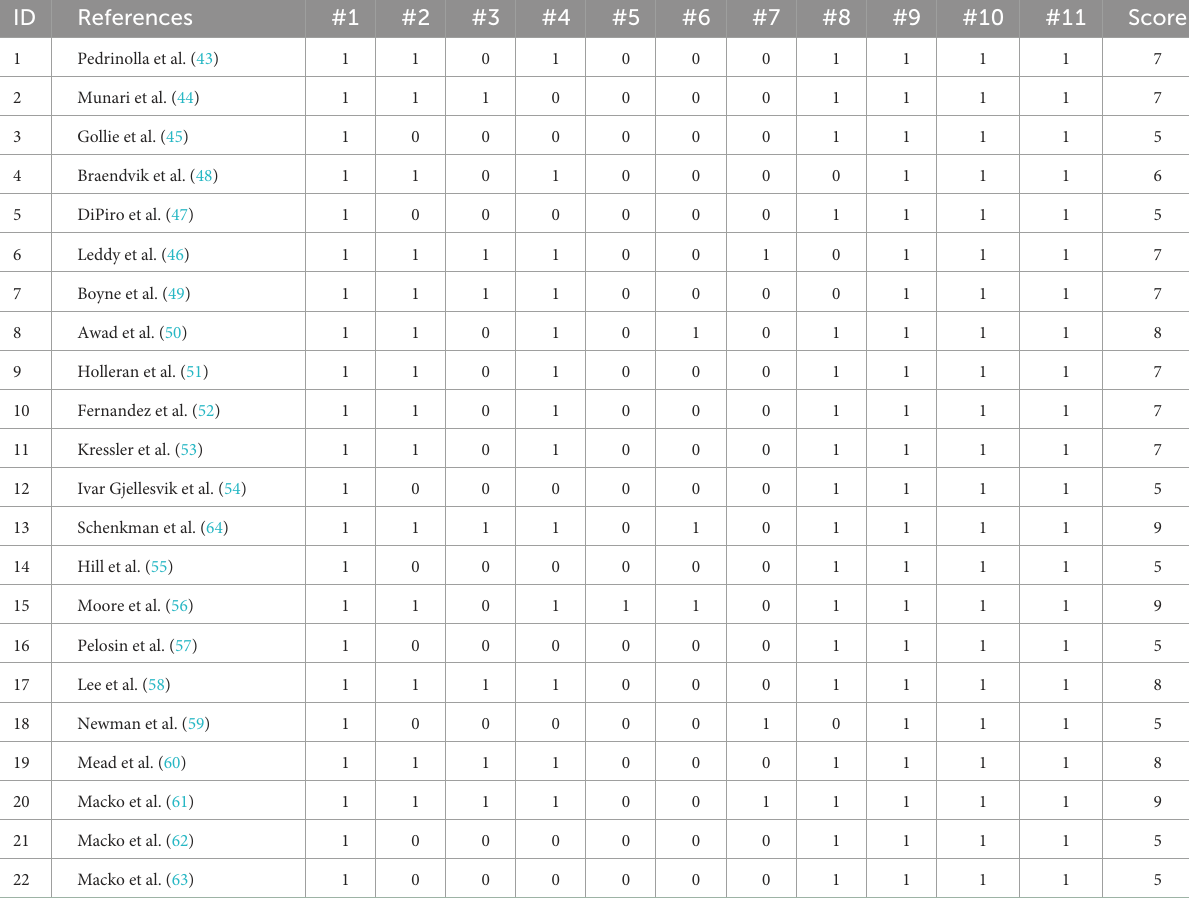
TABLE 2 Physiotherapy evidence database (PEDro) scores of the 22 included